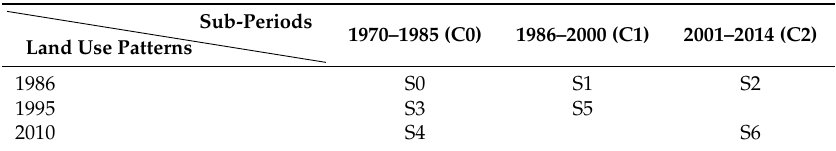
Table 5. Different scenarios for SWAT